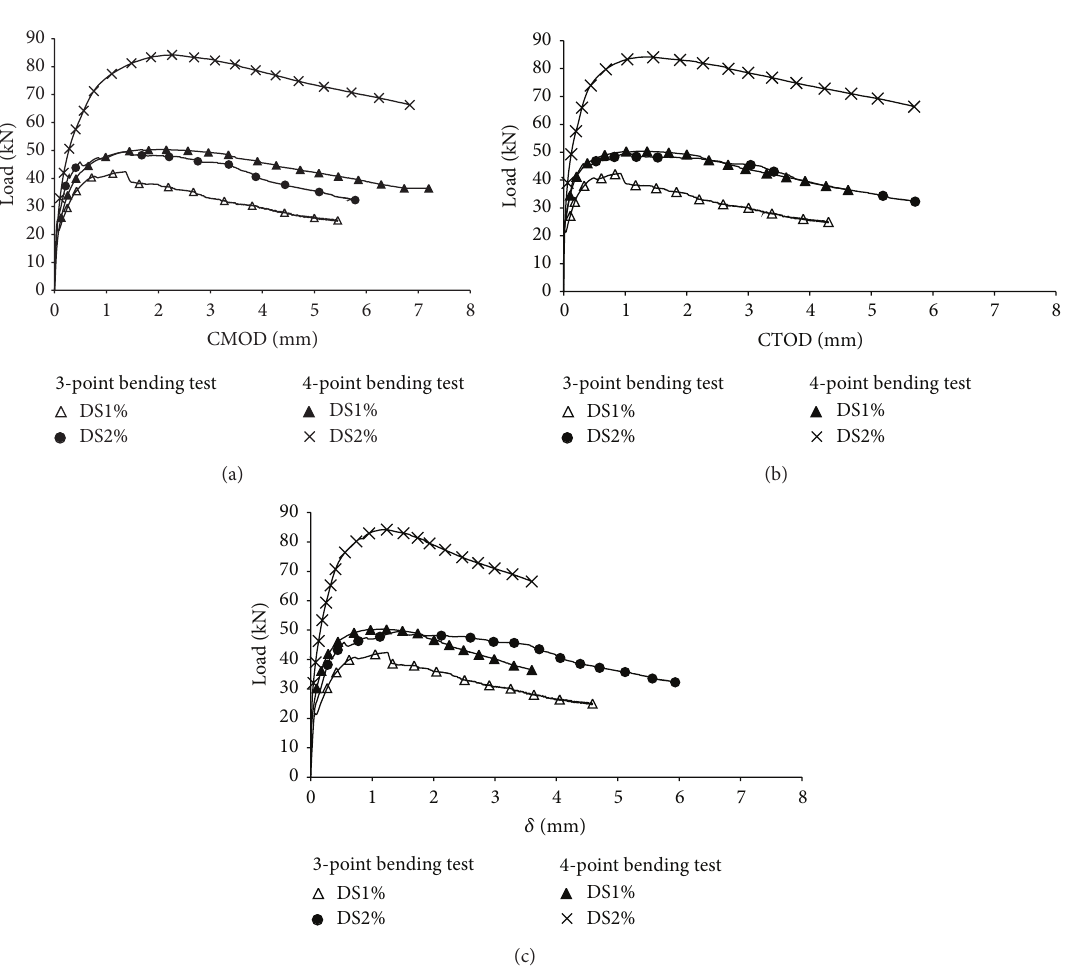
Figure 3: Typical experimental curves: (a) load-CMOD; (b) load-CTOD; (c) load-deflection.